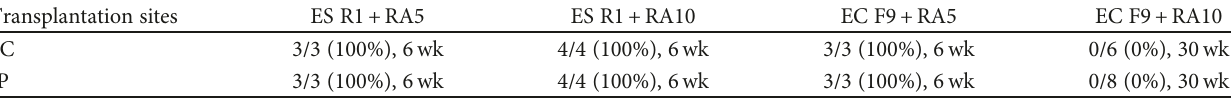
Table 1: Tumor development after transplantations of RA-stimulated ES R1 and EC F9 into immunode fi cient nude mice. Transplantation sites